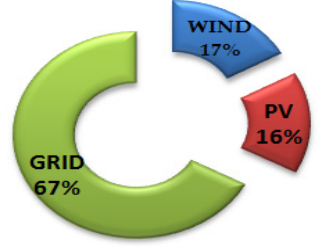
Figure 22. Grid with hybrid energy resources for optimum data.